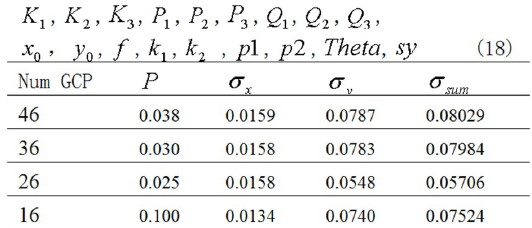
Table 1: The assessment using check points for 18 parameters.